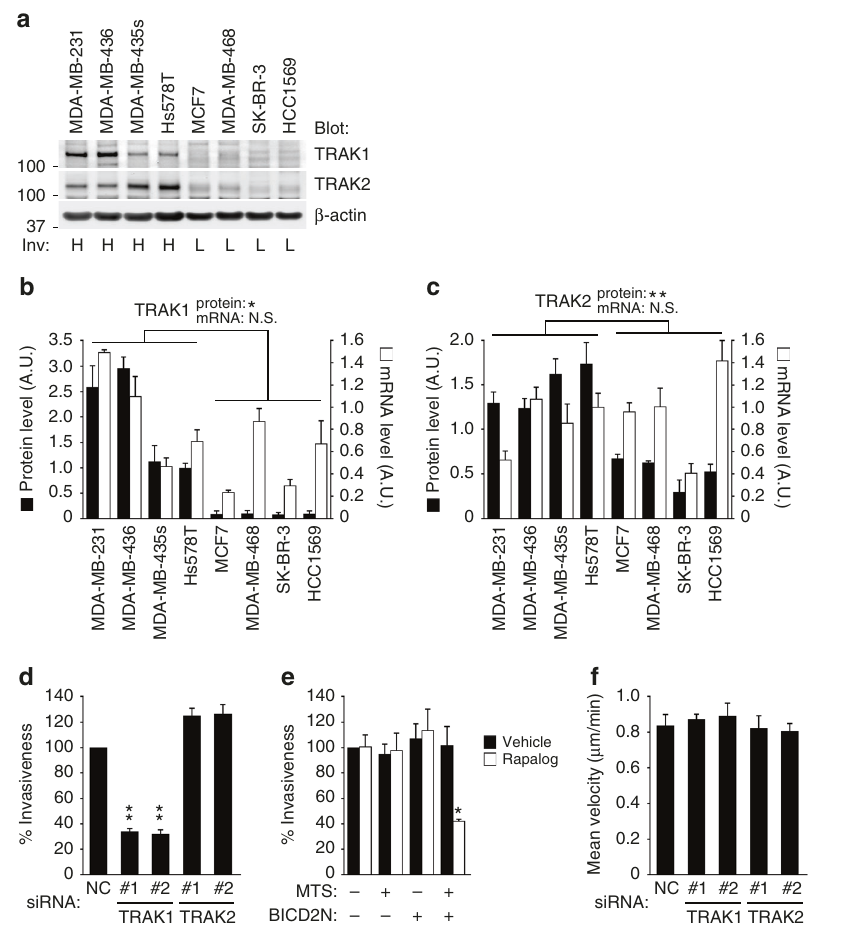
Fig. 6 Regulation of mitochondrial traf fi cking via FAs is essential for cancer invasion. a Protein expression of TRAK1 and TRAK2 in different breast cancer cell lines analyzed by western blotting. β -actin was also analyzed as a control. Invasiveness (Inv) is indicated as either high (H) or low (L). b , c Protein (black bars) or mRNA (white bars) expression of TRAK1 ( b ) and TRAK2 ( c ) quanti fi ed by densitometry of the western blots ( a ) or qPCR, respectively. d , e Matrigel invasion of MDA-MB-231 cells transfected with siRNAs targeting TRAK1 or TRAK2 ( d ) or stably expressing FKBP-MTS (MTS) and/or BICD2N-FRB* (BICD2N) ( e ). In e , cells were treated with vehicle or AP21967 (Rapalog) before and during the assay, as indicated. f Velocity of the random migration of MDA-MB-231 cells transfected with siRNAs targeting TRAK1 or TRAK2. All the graphs indicate the mean ± SEM for three independent experiments. * and ** P < 0.05 and P < 0.005 (two-tailed t -test, adjusted by the Holm – Sidak method), compared to the corresponding samples,